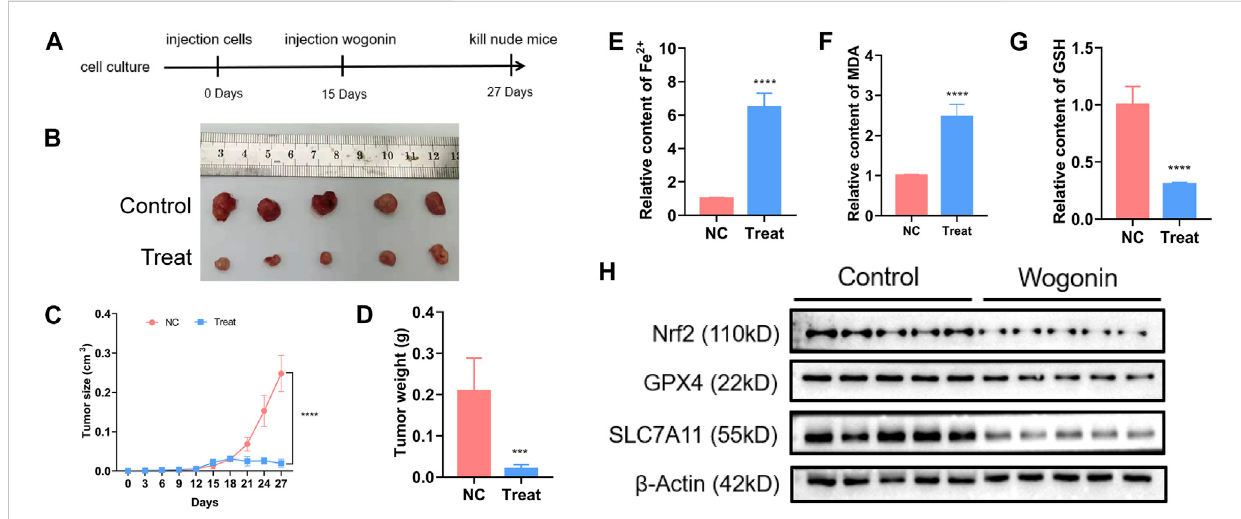
FIGURE 7 Wogonin improved ferrous iron and lipid oxidation in vivo . (A, B) Representative images of the nude mice with xenografted pancreatic cancer showed thattumorsize wassigni fi cantly smaller inthemicetreated withwogoninatthedosageof60 mg/kgfor consecutive 12 days thanthat incontrol group. (C, D) Statistical analysis oftumor volumes con fi rmed as well that wogonin inhibited tumor growth invivo . (E) Iron assay showed ferrousiron level was signi fi cantly higher in wogonin-treated group than that in control group in vivo . (F) MDA assay proved that lipid peroxidation became more apparent in wogonin-treated group when compared with control group in vivo . (G) GSH assay showed GSH level was signi fi cantly lower in wogonin- treated group than that in control group in vivo . (H) Western blotting analysis revealed that wogonin induced marked downregulation of Nrf2, GPX4